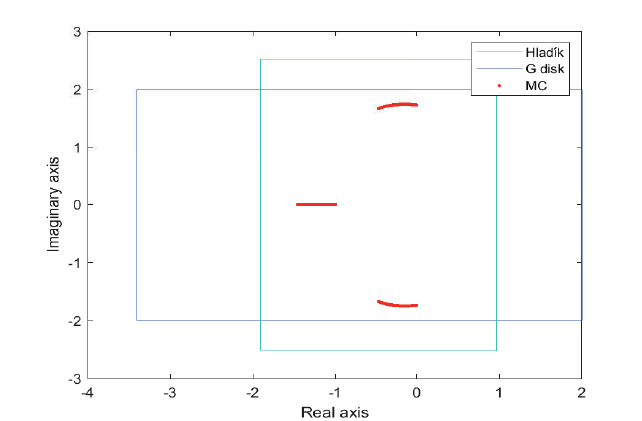
Fig. 2. Eigenvalue set and enclosures of Example